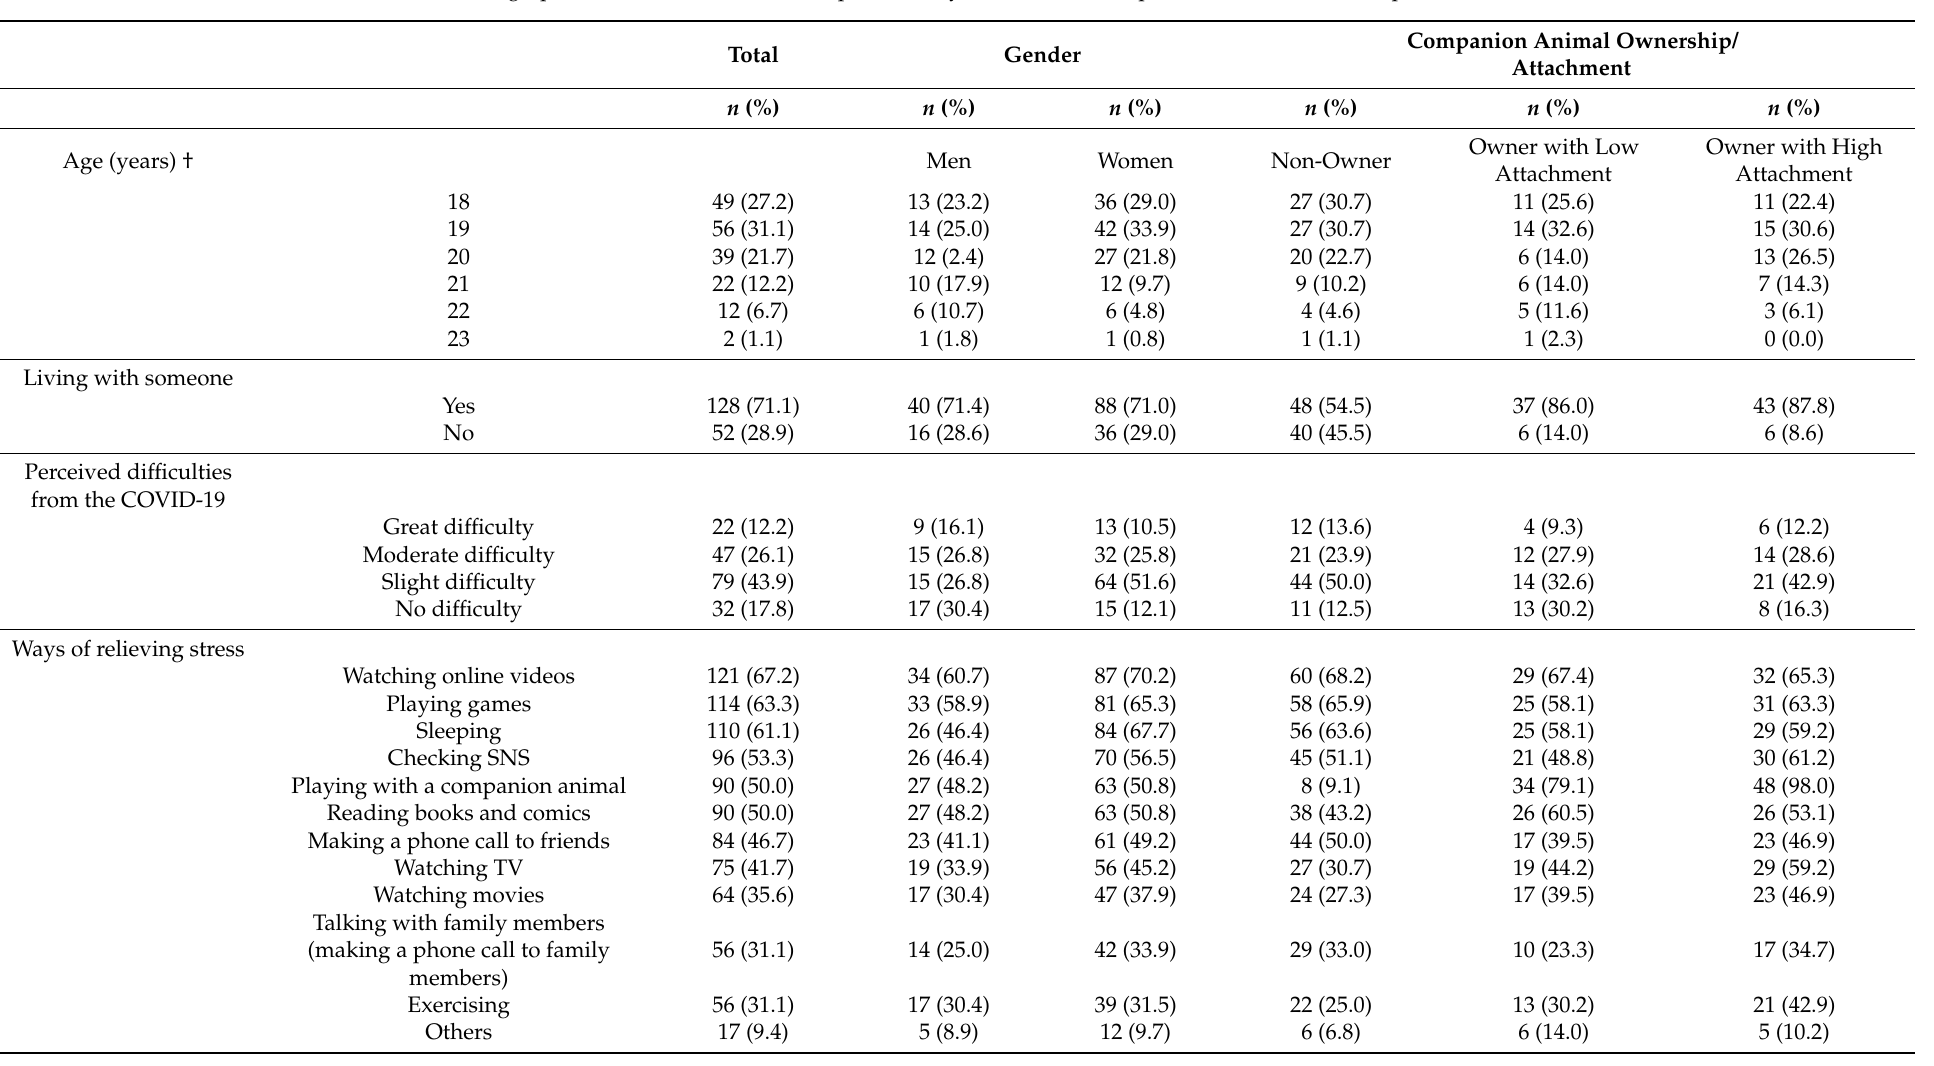
Table 1. Demographic Characteristics of the Respondents by Gender and Companion Animal